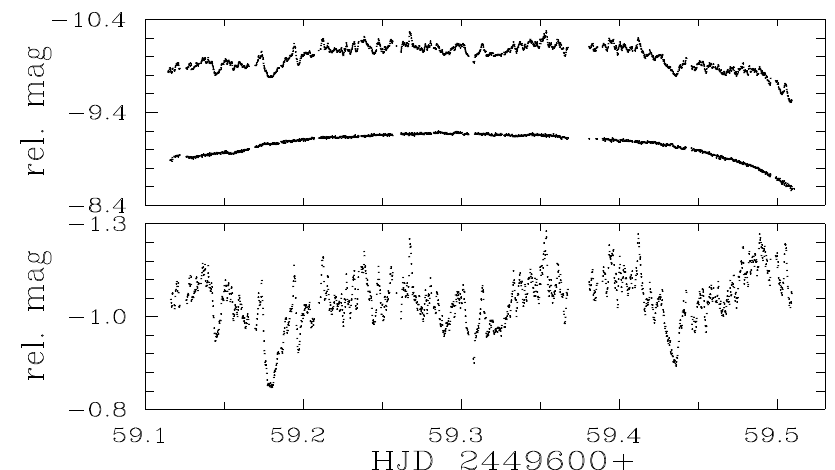
Fig. 5. 10 h long light curves of TT Ari and a comparison star (upper panel) on the night 02/03 Nov. 1994 in the multi-site campaign (see Andronov et al. 1999). Bottom panel shows the differences variable minus comparison